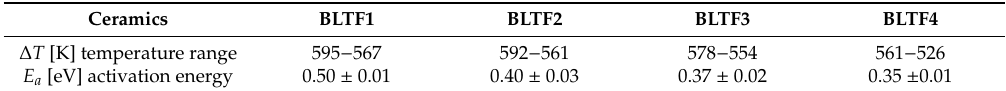
Table 4. The values of the energy activation of the conductivity process and the temperature range